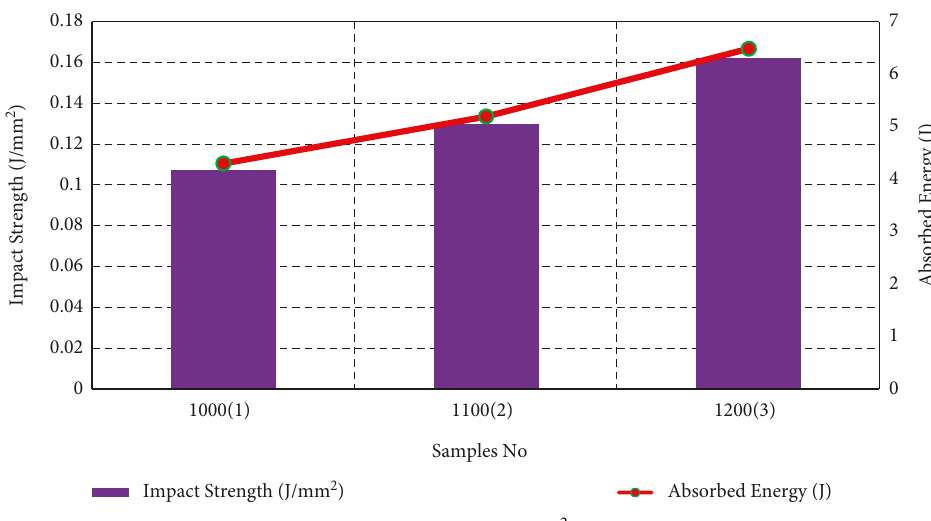
Figure 19: Samples vs. impact strength (J/mm 2 ) and absorbed energy ( J ).